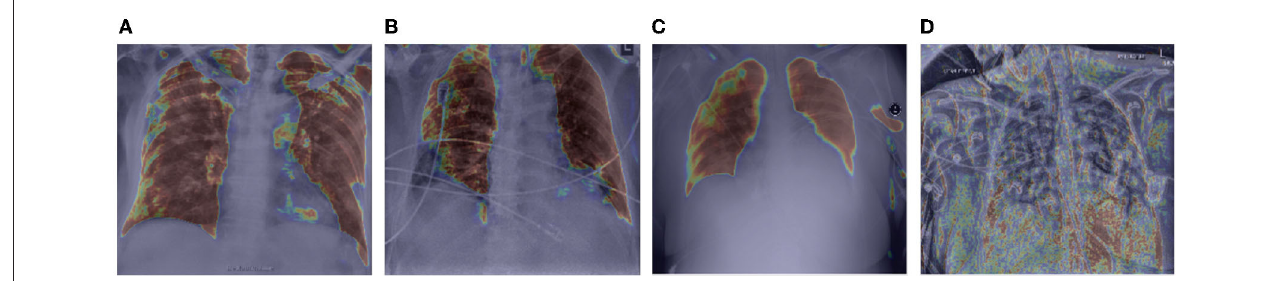
FIGURE 3 | Example chest X-ray images (A–D) from the COVIDx CXR-2 benchmark dataset overlaid by the global attention output from the proposed MEDUSA network. The red regions indicate higher attention while blue regions indicate lower global